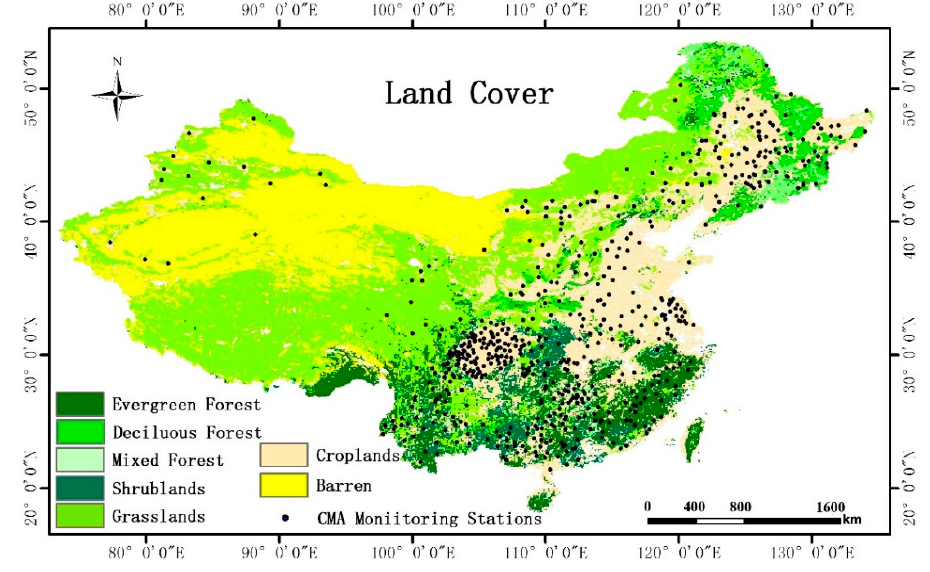
Figure 3. The spatial distribution of seven land cover types and 655 CMA monitoring stations in continental China.